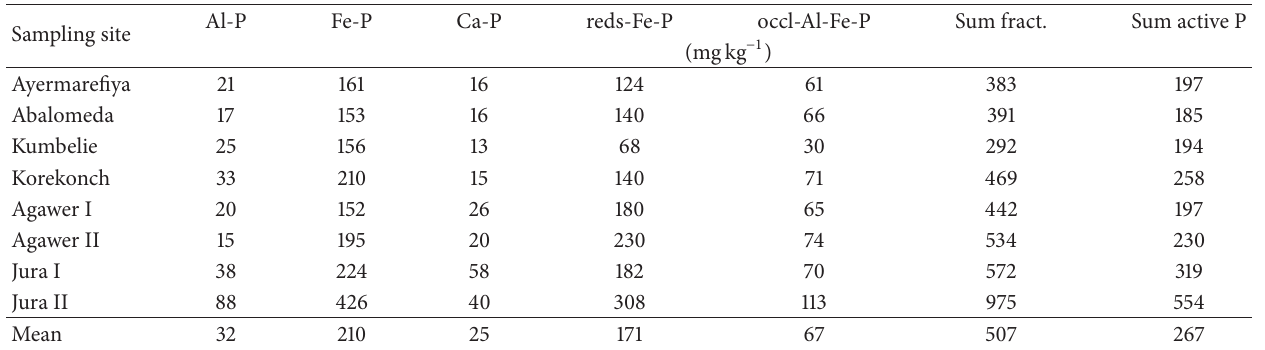
Table 6: Inorganic P fractions and percentage distribution of active P forms.